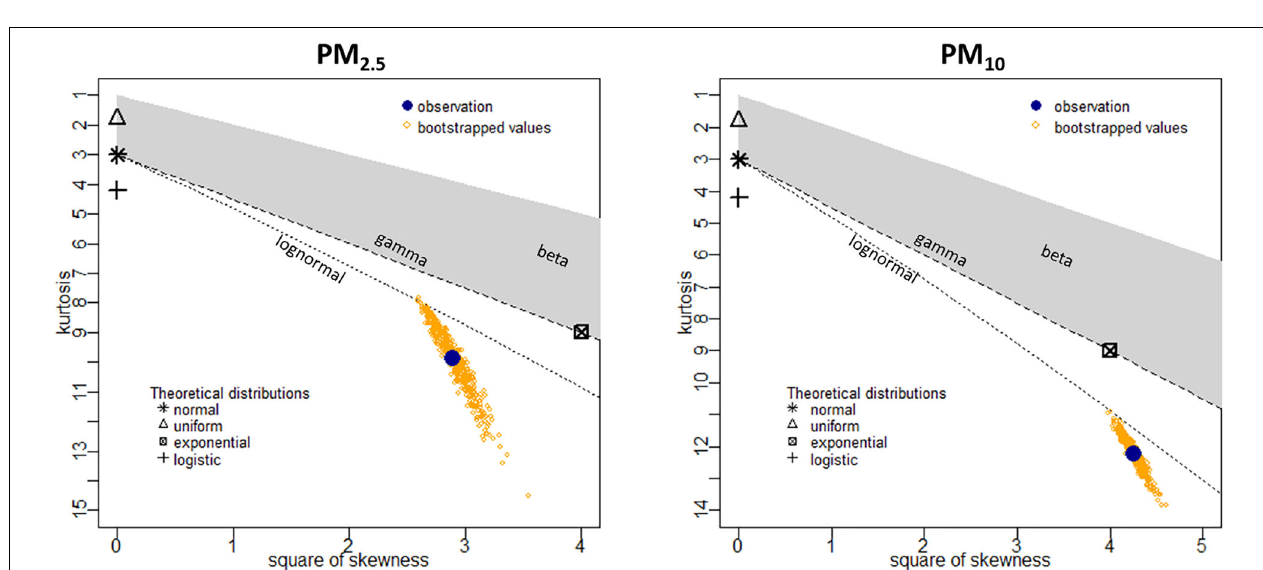
FIGURE 6 | Empirical distributions of measured concentrations of PM 2 . 5 (left chart) and PM 10 (right chart).